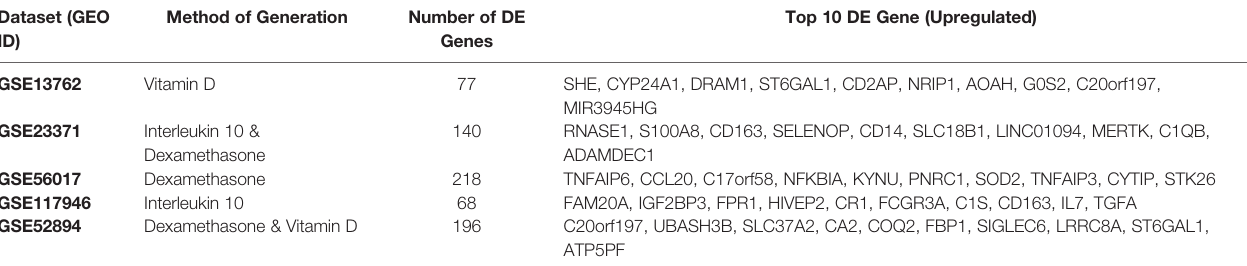
TABLE 2A | Top 10 differentially upregulated genes in tolDC. Dataset (GEO ID)